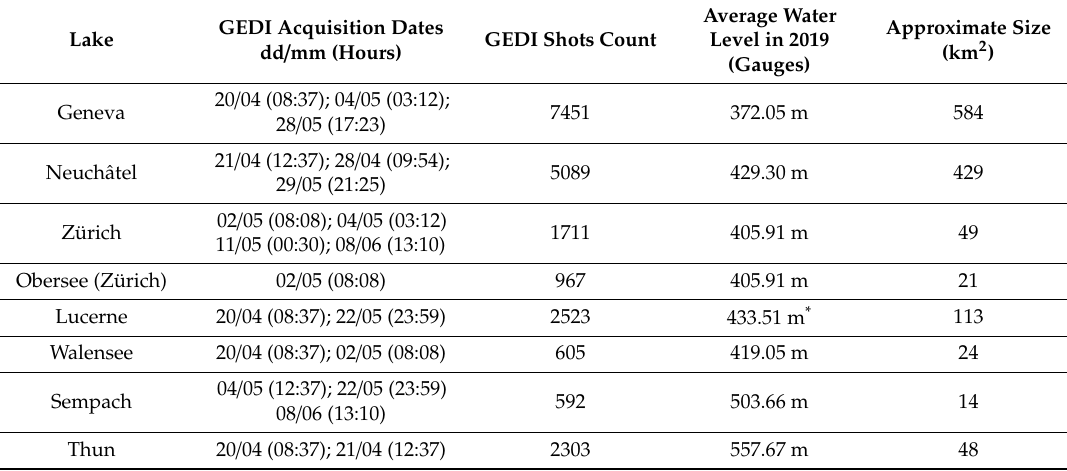
Table 1. Global Ecosystem Dynamics Investigation (GEDI) acquisition dates between April and June 2019 and available GEDI shot count over the studied lakes. The star (*) indicates that the average level of water was available for 2018, not